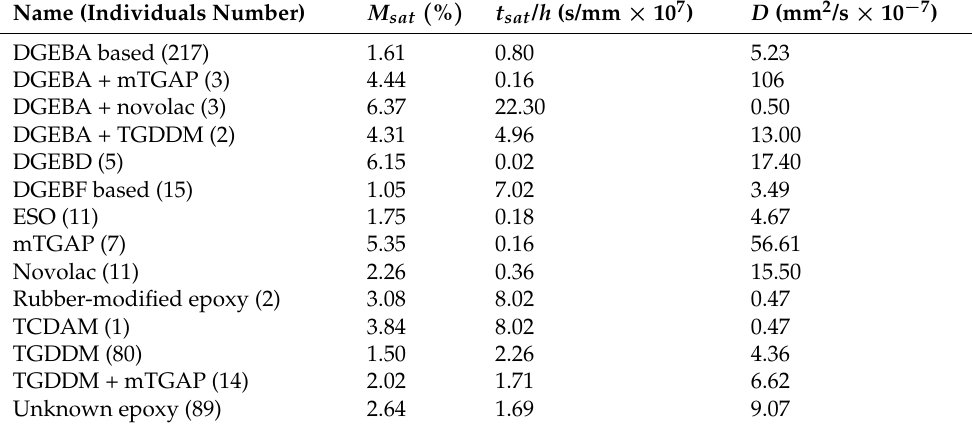
Table 2. Medians of M sat , t sat / h et D as a function of epoxy prepolymer type. List of pre-polymers and entire box plots are available as Supplementary Materials (Figures S1 and